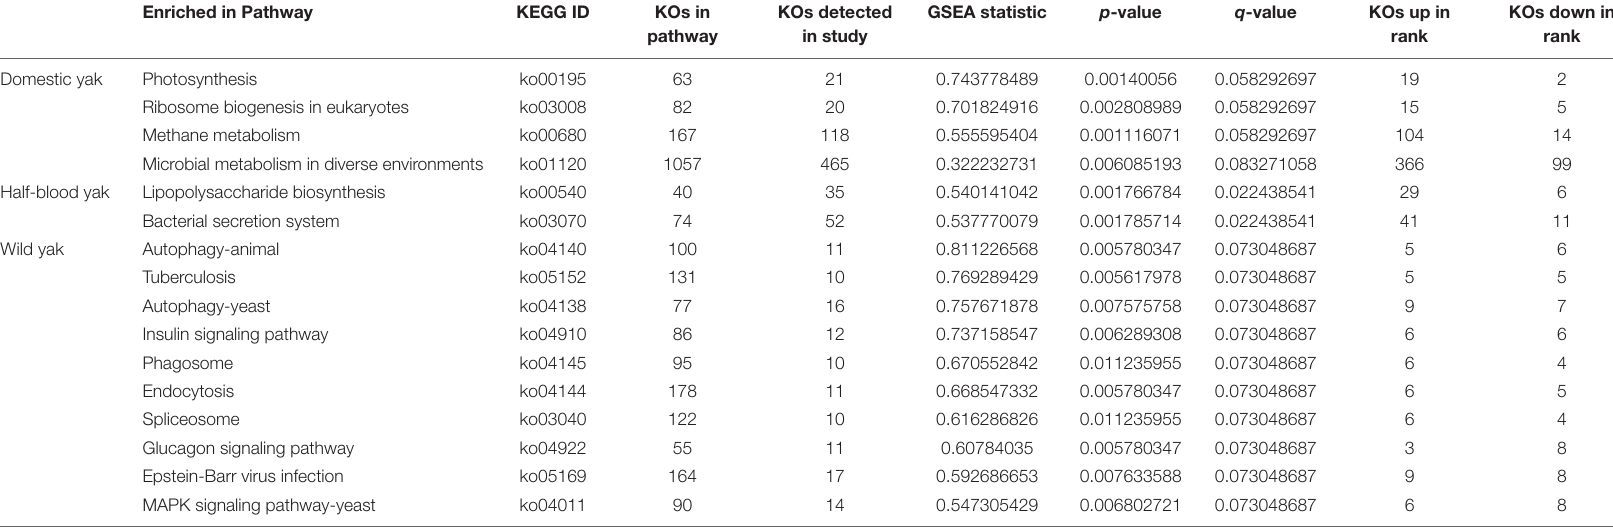
TABLE 1 | Metabolic pathways enriched in different types of